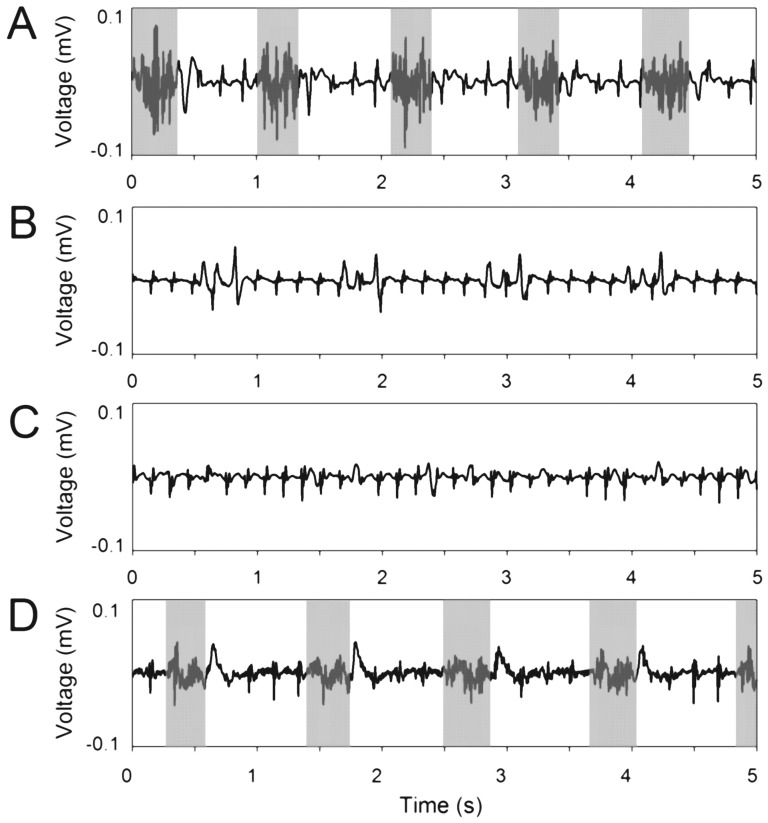
Spontaneous electromyographic activity of a non-denervated (A) and denervated sternal (B), mid-costal (C) and crural (D) hemidiaphragm 1 day after phrenicotomy.While the non-denervated hemidiaphragm shows characteristic, inspiration-related electromyographic bursts (gray areas; manually labelled), on the denervated side mainly electrocardiographic traces were observed. Burst epochs were manually identified and used for electromyographic analysis (A, B: grey intervals). Otherwise, if burst epochs were not clearly identifiable, the complete recording was included in analysis (B, C).